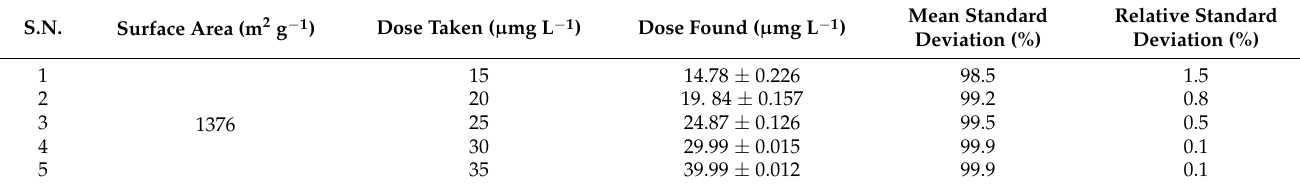
Table 7. Accuracy and precision of the spectrometric method for the determinations of RhB dye.